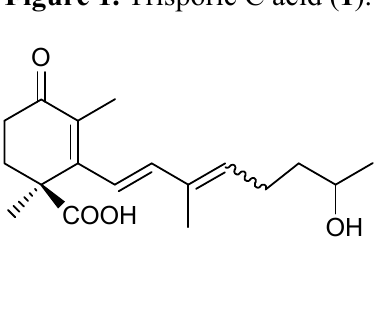
Figure 1. Trisporic C acid ( 1 ).